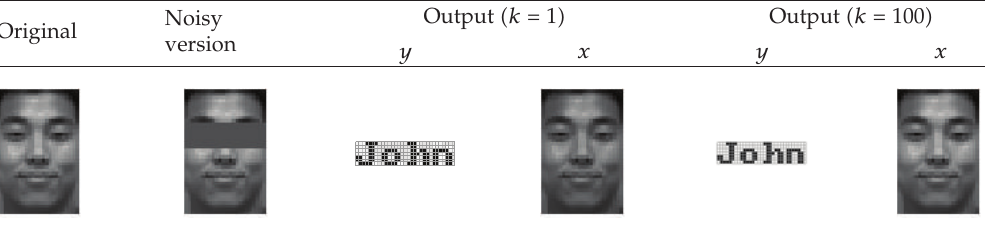
Table 2: Network recall for an incomplete pattern.